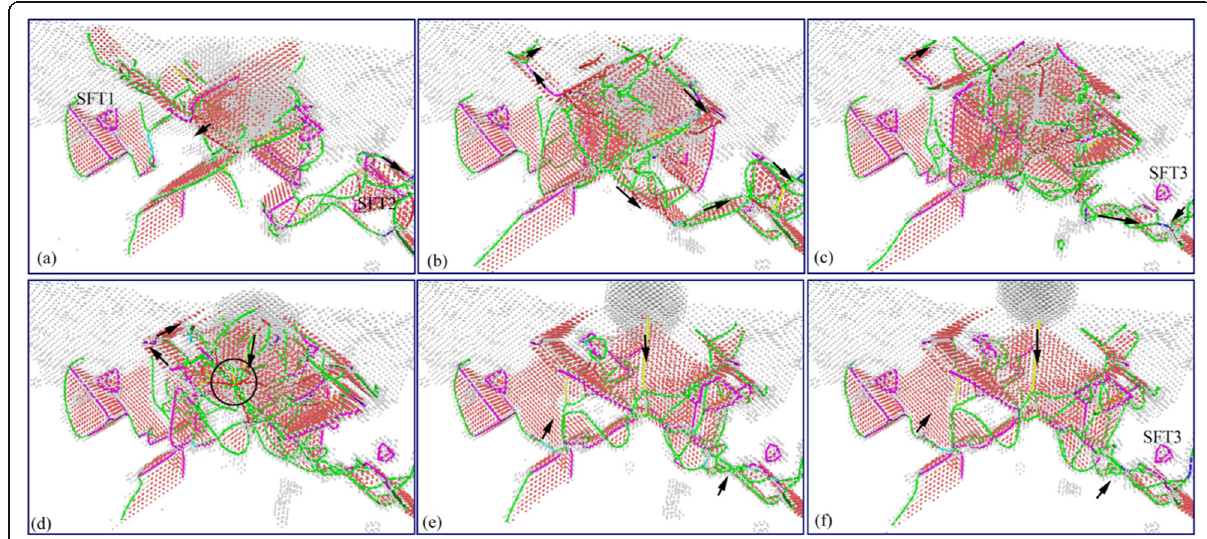
Fig. 10 Distribution of subsurface dislocations in unloading process of nano-indentation (color online). The corresponding indentation depths of a – f are 4 nm, 3 nm, 2 nm, 1 nm, 0 nm, and − 1 nm, respectively. Color scheme: deep blue for perfect dislocations, green for Shockley dislocations, pink for Stair-rod dislocations, yellow for Hirth dislocations, light blue for Frank dislocations, and red for unidentified